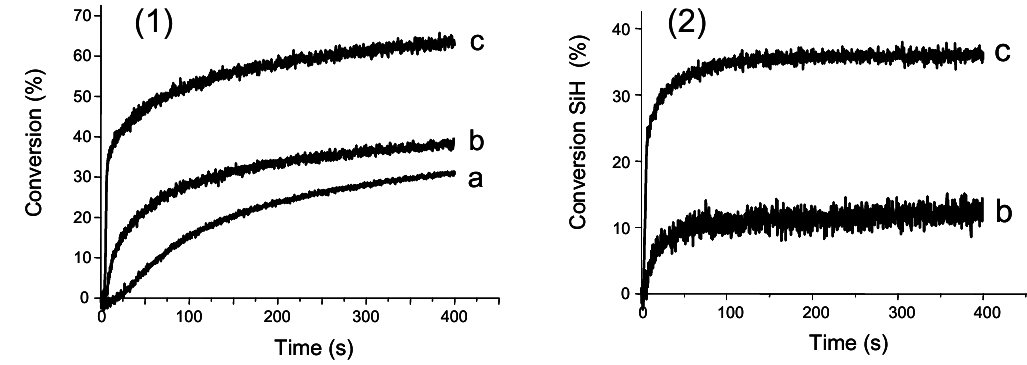
I + (1%/1% w/w), (b) phenyl 2 I + (1%/3%/1% w/w), and (c) phenyl 2 Si-H/Ph I + (1%/3%/1% w/w). ( 2 ) Conversion of 3 2